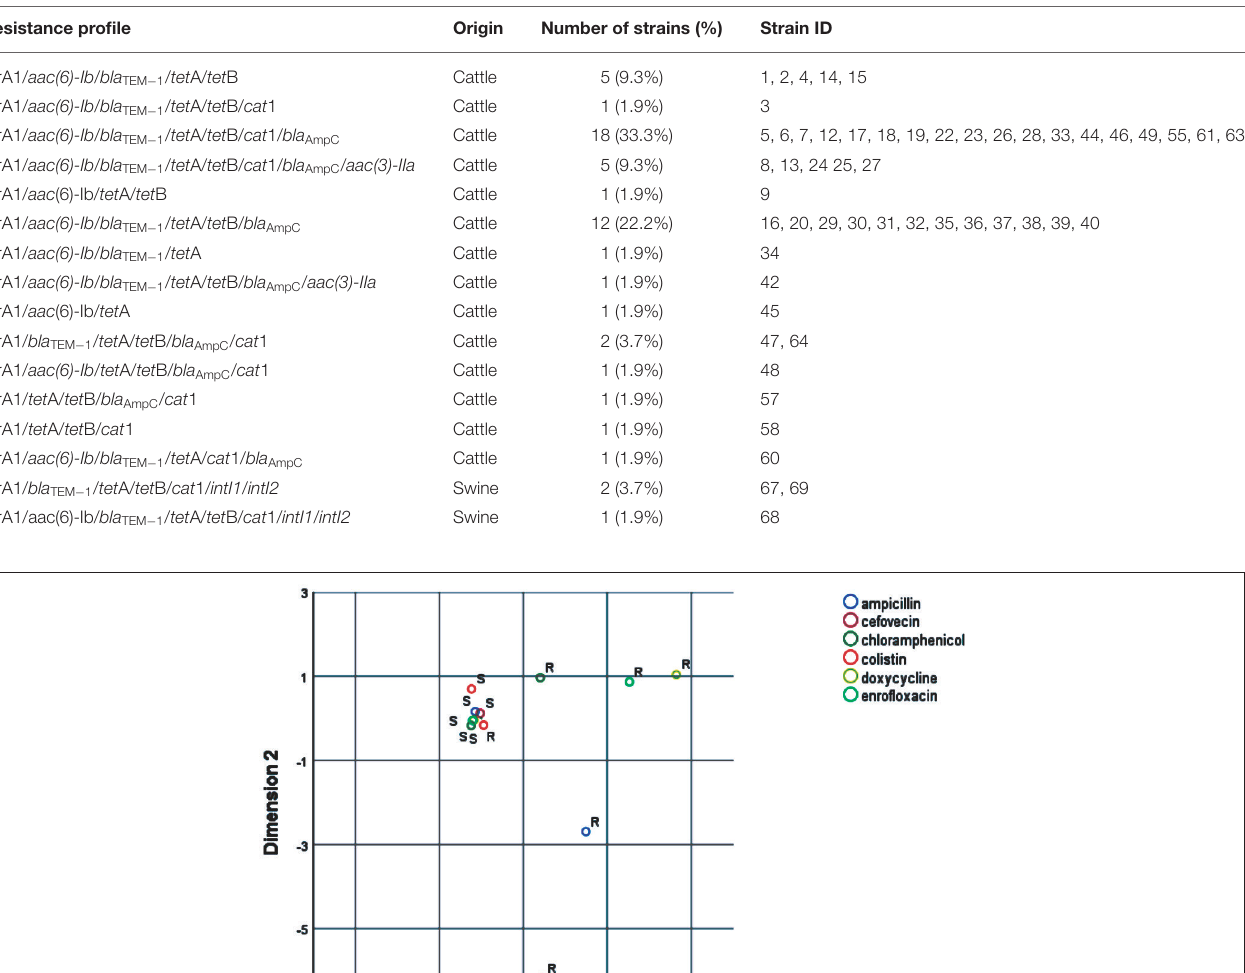
TABLE 4 | Genotypic resistance profiles detected in STEC strains isolated from cattle and swine. Resistance profile